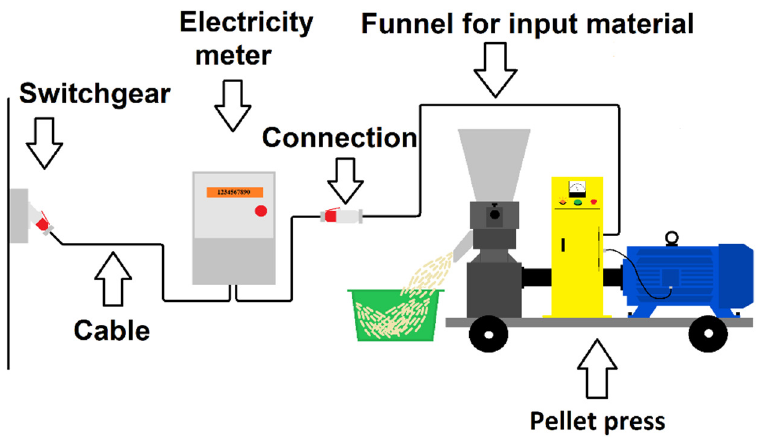
Figure 3. The connection of the electricity meter to the pellet press.